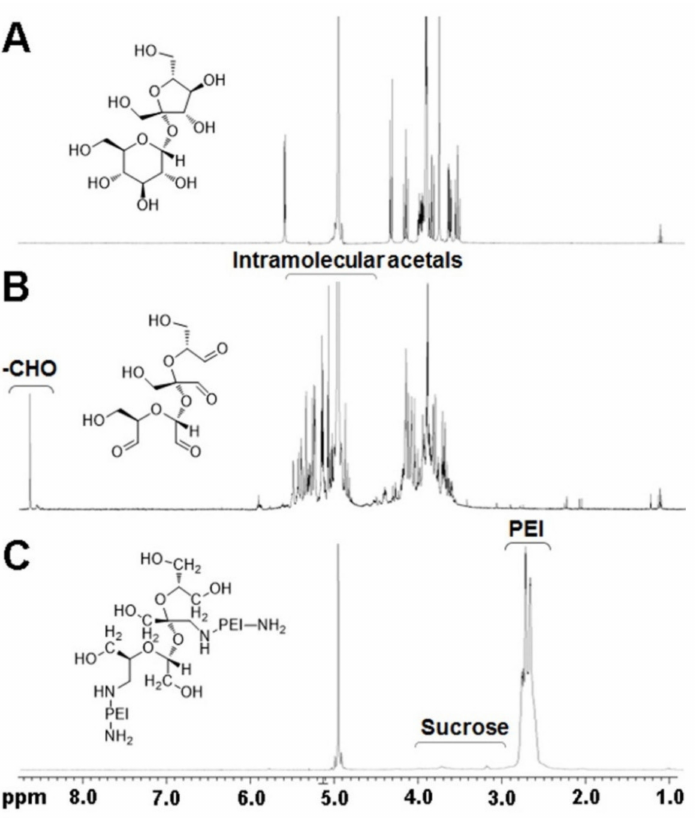
Figure 1. 1 H NMR spectra and chemical structures of ( A ) sucrose, ( B ) oxidized sucrose, and ( C ) sucrose- polyethylenimine (SP2K) polymer. Table 1. Characterization of SP2K polymers. Molar ratios mean the ratio (amine of PEI2K/aldehyde of oxidized sucrose).